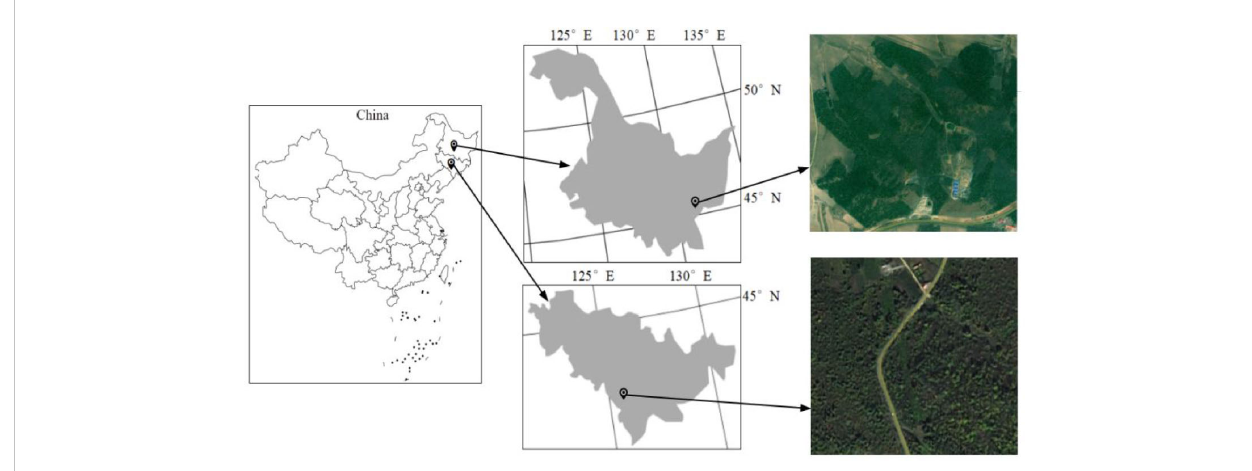
FIGURE 1 Geographical location of wood